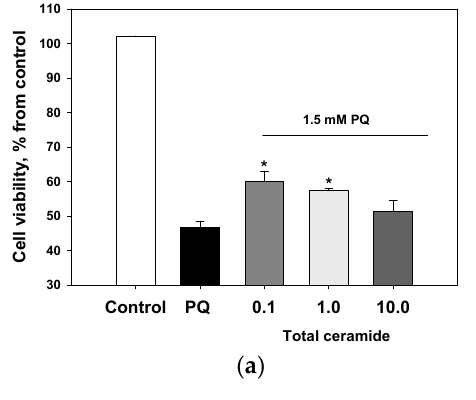
Figure 8. Protective e ff ects of total ceramide against neurotoxicity of paraquat (PQ): the impact of pre-incubation with phytoceramides on the viability of ( a ) Neuro-2a cells (24 h pre-incubation) and ( b ) SH-SY5Y cells (48 h pre-incubation). The data are presented as m ± se ( n = 3). * p < 0.05 compared to cells exposed to paraquat alone. Crambescidin 359 reduced ROS formation (maximum 17.9 ± 4.6%, 10 µM concentra-